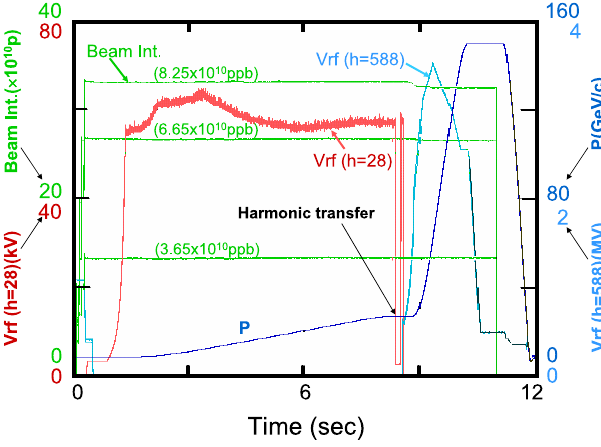
FIG. 6. (Color) Experimental data for the acceleration scheme for three different beam intensities. 8 : 9 – 149 : 6 GeV =c momen- tum ramp (P, blue), 2.5 MHz peak rf voltage [Vrf ( h (cid:1) 28 ), red], 53 MHz peak rf voltage [Vrf ( h (cid:1) 588 ), cyan], and the beam intensity [Beam Intensity, green] versus acceleration cycle time. Four 2.5 MHz bunches are accelerated from 9 to 150 GeV. The 2.5 MHz bunch intensities for three cases are shown. The longitudinal emittances of the 2.5 MHz bunches at 9 GeV were about 1.0, 2.0, and 2.3 eV s (with an error of (cid:8) 20% ). The acceleration efficiency found to be in the range of 97.5%–